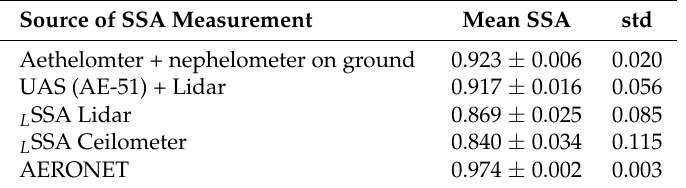
Table 3. Single scattering albedo measured/retrieved by different methods. Mean value with confidence intervals and standard deviations are presented. L Single scattering albedo (SSA) values are obtained with described in Section 3.2 method with extinction coefficient retrieved from different remote sensing systems (lidar,